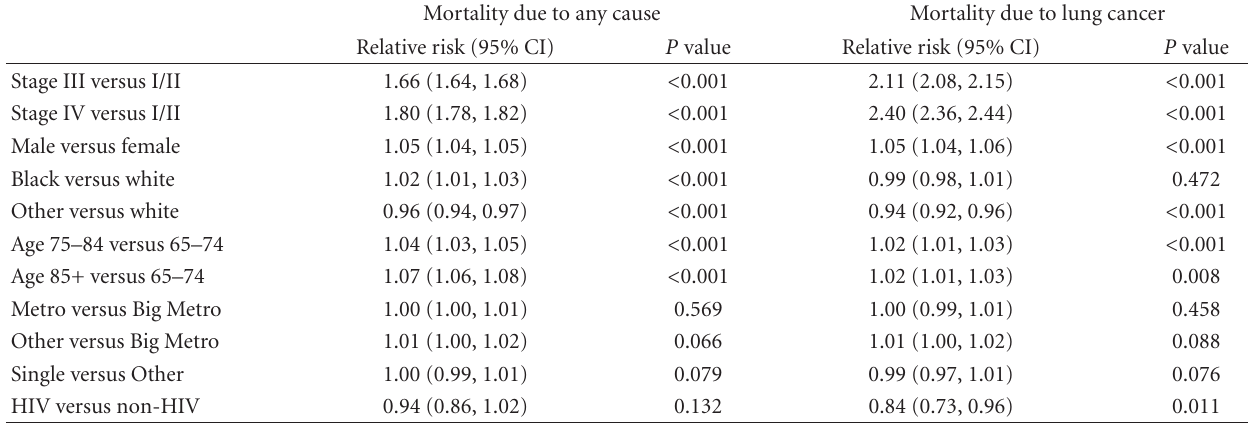
Table 3: Relative Risk (RR) for all causes mortality and lung cancer mortality. Mortality due to any